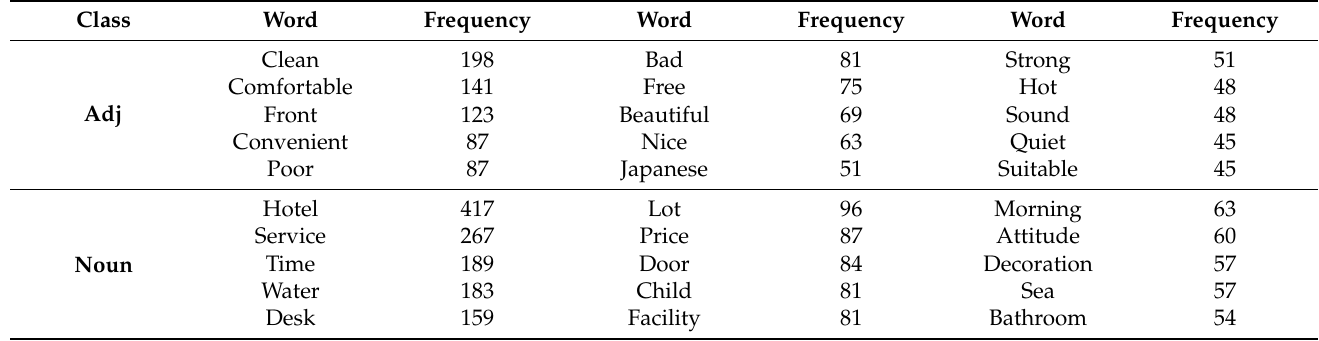
Figure 2. Location, room type map and plans of the case area. Source: bzdt.ch.mnr.gov.cn (ac- cessed on 25 April